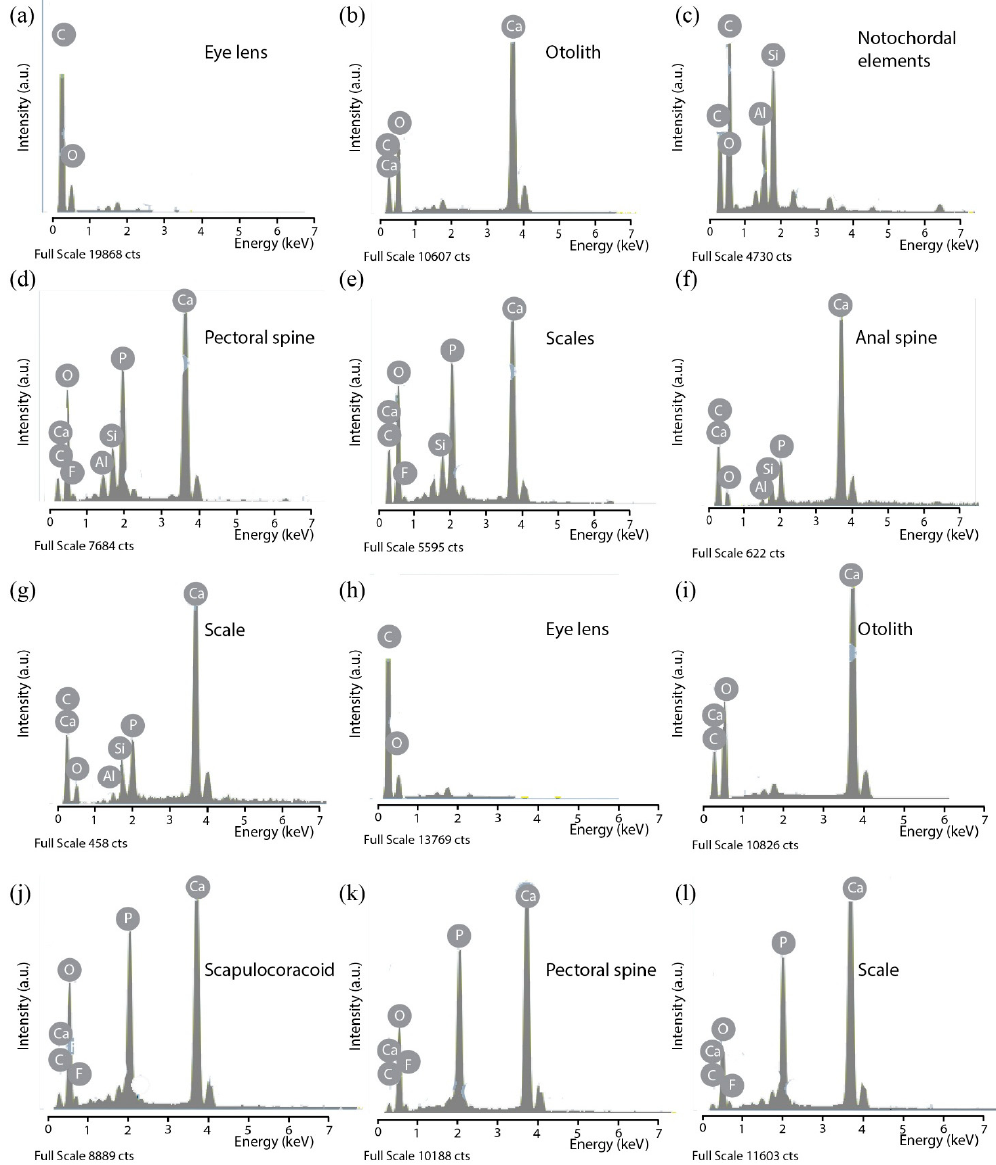
Figure 4. Representative spectra of juvenile Triazeugacanthus samples using EDX punctual microanalysis. ( a )–( e ) MHNM 03-1252. ( f ), ( g ) MHNM 03-398. ( h )–( l ) MHNM 03-2684. Note that the intensity of the oxygen peak is non-significant and depends essentially on the vacuum level in the chamber of the environmental SEM. See Figure 3 for chemical elements legend.